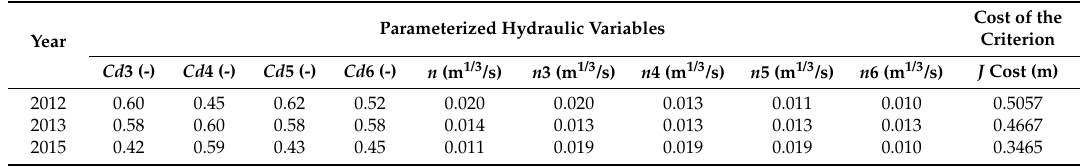
Table 5. The values of the nine parameterized variables and of the cost of the criterion obtained from the optimization